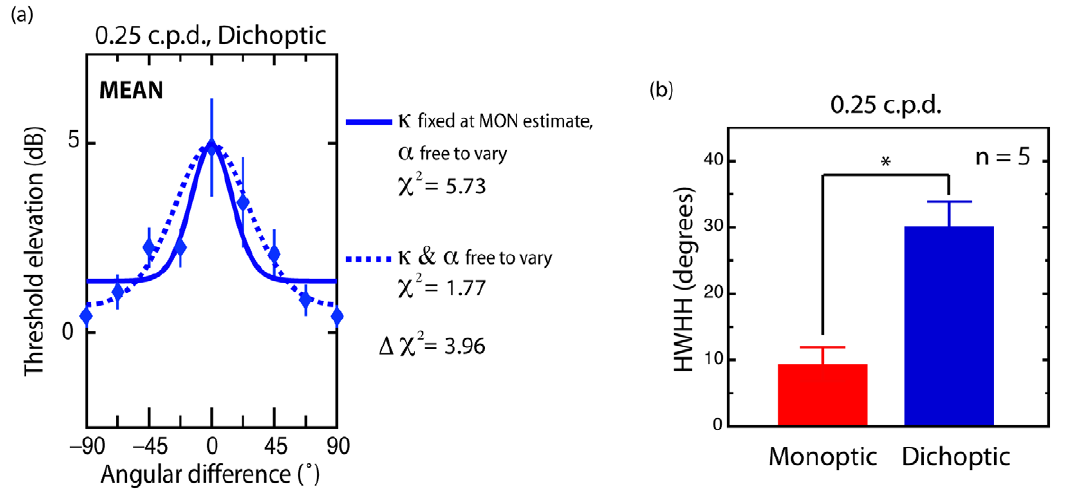
Figure 5. Effect of ocular presentation mode on bandwidths. (a) Comparison of circular variance ( k ) as a function of ocular presentation mode. Data represent threshold elevation averaged across subjects in the 0.25 c.p.d. dichoptic condition. In one case, Equation 2 is fit with two free parameters ( k and a ; solid curve) while in the other it is fit with only one free parameter ( a ), with k was fixed at the value found in the 0.25 c.p.d. monoptic condition (dashed curve). The difference between these fits exceeds the critical value of 3.84 (p . .05; 1 degree of freedom), indicating broader bandwidths (smaller estimates of k ) in the dichoptic condition. (b) Average estimates of bandwidth (HWHA) measured under monoptic and dichoptic adaptation conditions (0.25 c.p.d.) using Equation 1 for the dichoptic and Equation 2 ( k and a both free to vary) for the monoptic